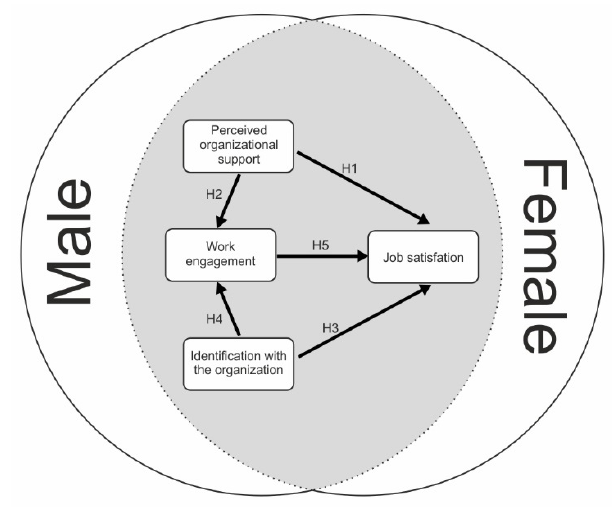
Figure 1. Conceptual model of hypotheses to be tested.